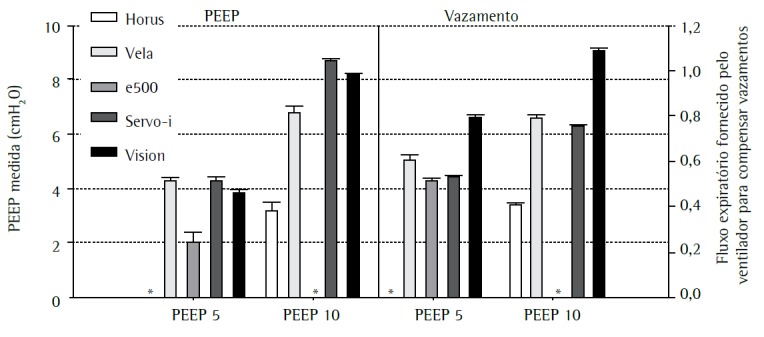
 Valores medidos de positive end-expiratory pressure (PEEP, pressão
expiratória final positiva; painel à esquerda) e fluxo expiratório fornecido
pelo ventilador (painel à direita) para compensar o vazamento de ar em PEEP
de 5 cmH2O (PEEP5) e 10 cmH2O (PEEP10), na forma de média ± dp. Como se pode
observar, os ventiladores Horus e e500 não compensaram adequadamente os
vazamentos, fornecendo menos de 0,6 L/s de fluxo compensatório, e não foram
capazes de manter o nível estabelecido de PEEP. *Medida não realizada em
virtude de autodisparo.